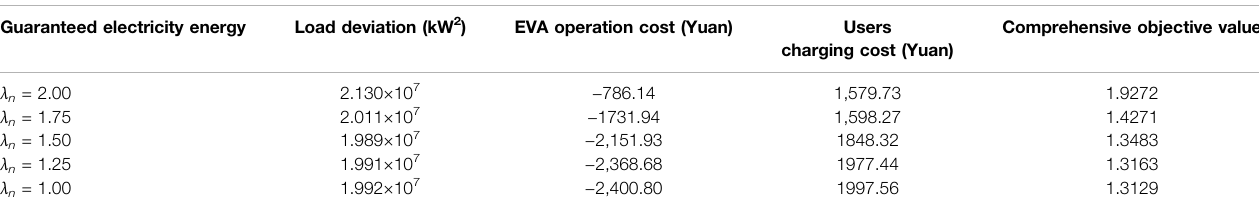
TABLE 5 | Results under different guaranteed electricity energy. Guaranteed electricity